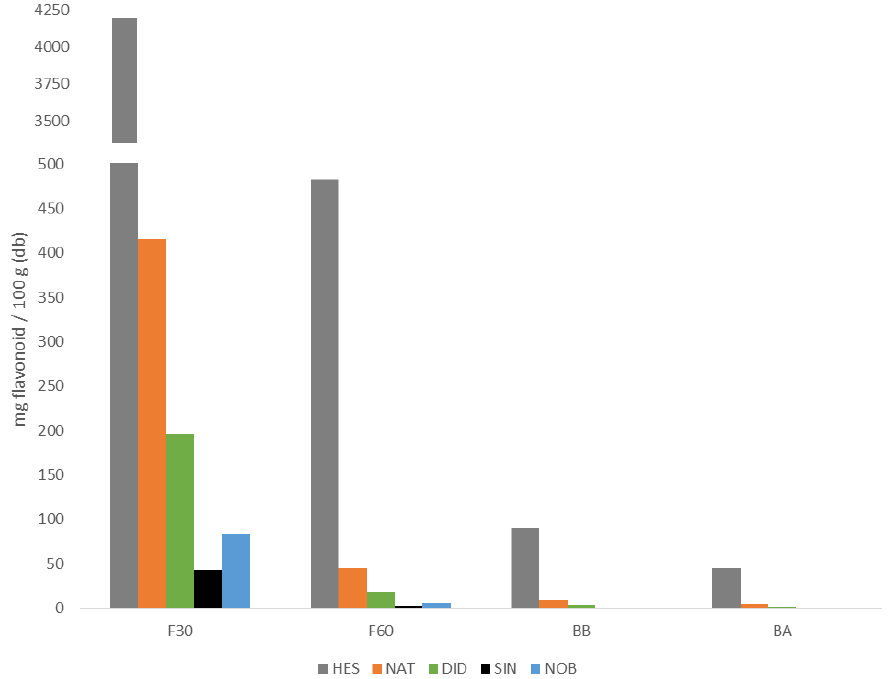
Figure 4. Flavonoid content of narirutin (NAT), hesperidin (HES), didymin (DID), sinensetin (SIN), and nobiletin (NOB) in the different phenolic extracts studied (codes according to Section 2.2).